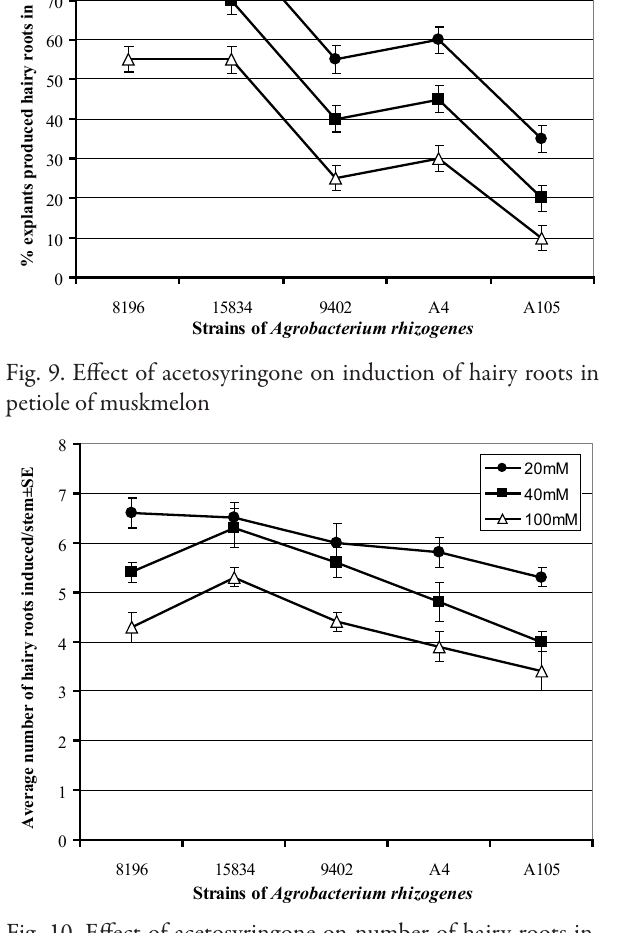
Fig. 10. Effect of acetosyringone on number of hairy roots in- duced in stem of muskmelon